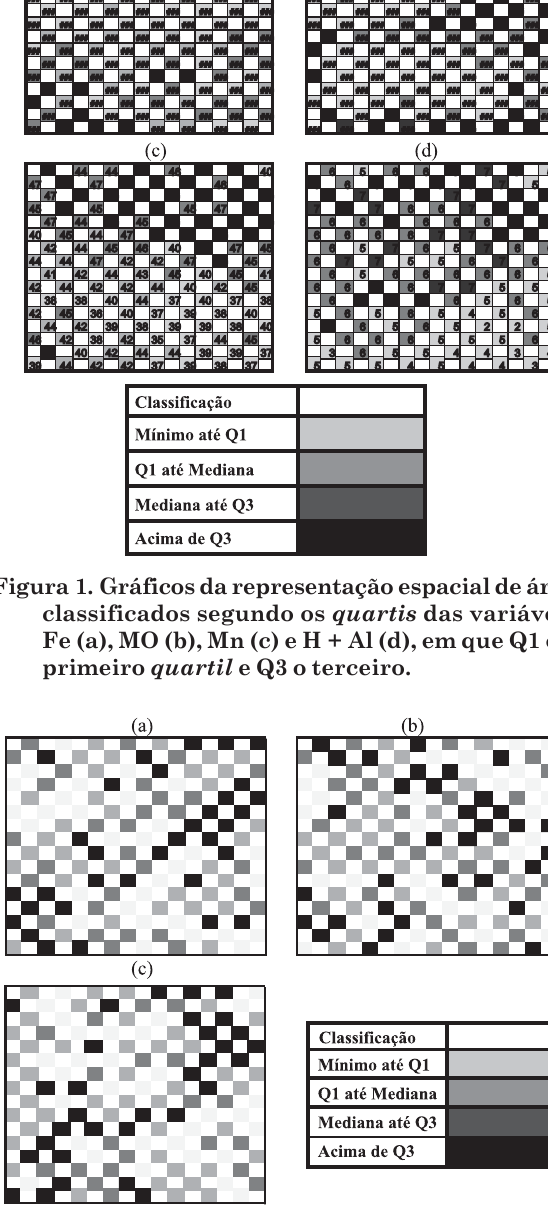
Figura 2. Gráficos da representação espacial de área classificados segundo os quartis dos resíduos de MO (a), Mn (b) e H + Al (c), em que Q1 é o primeiro quartil e Q3 o